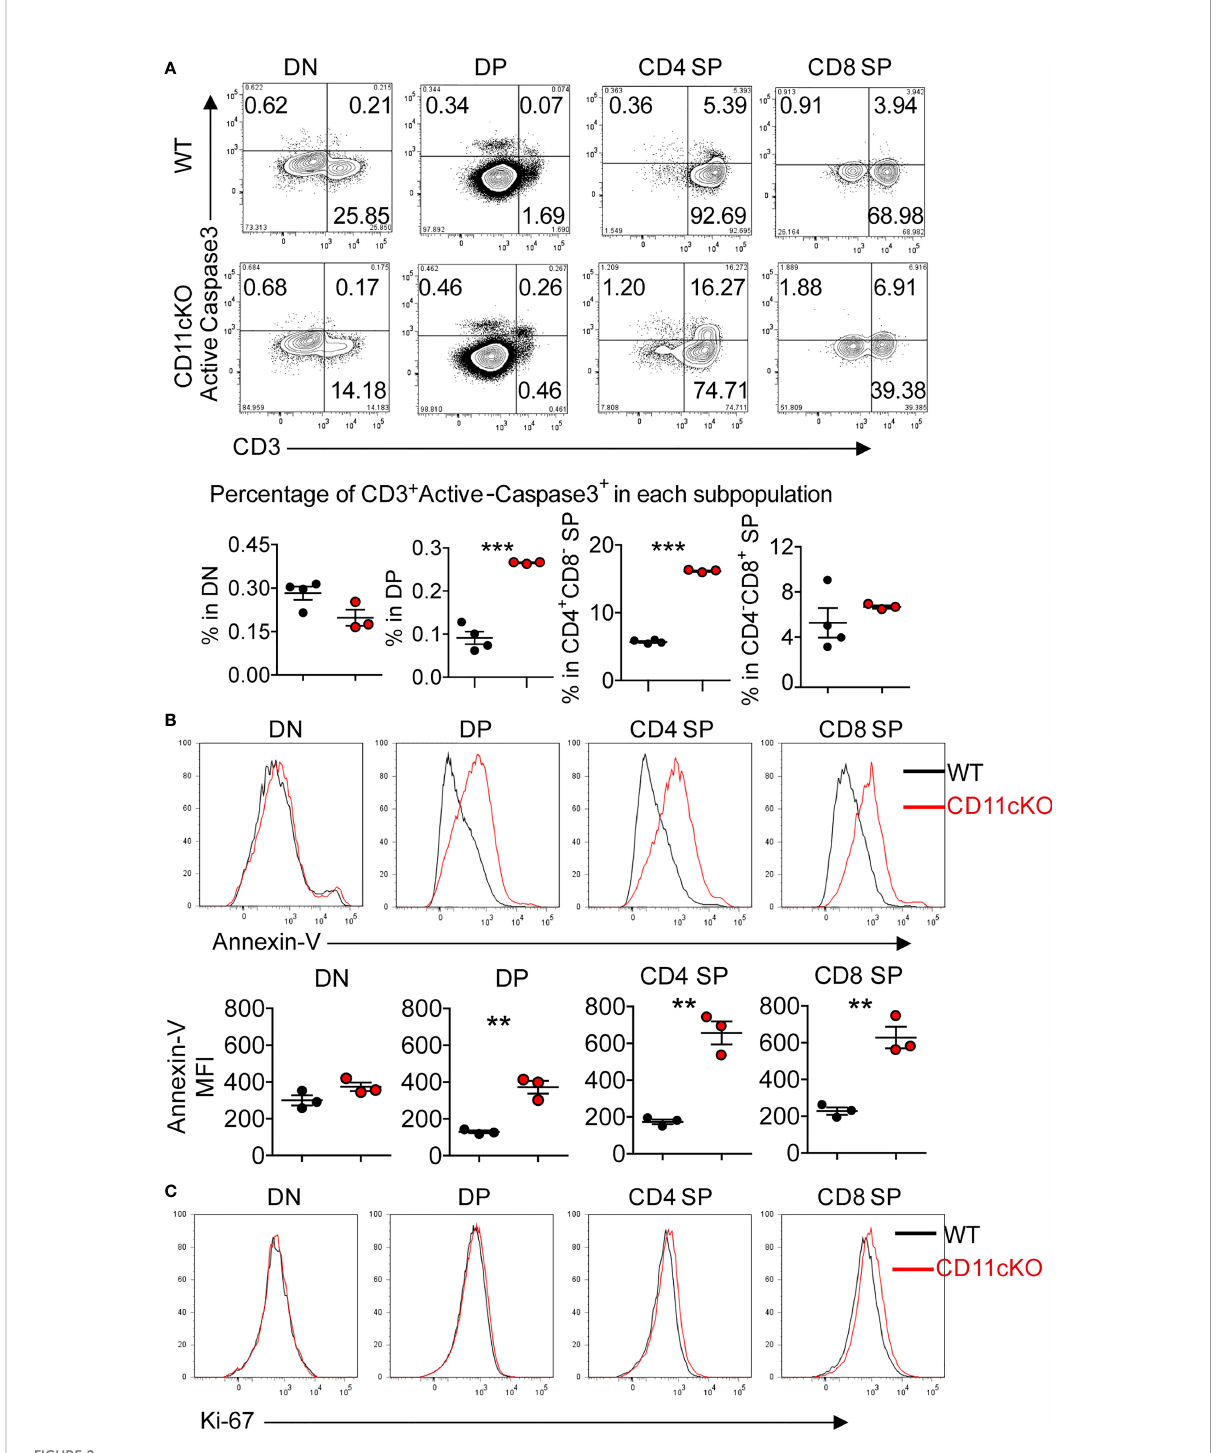
FIGURE 2 Apoptosis and proliferation analysis in CD11cKO mice. (A) Up panel: representative FACS data gated on different thymic T cell subsets with active cleaved caspase 3 expression; Bottom panel: Dot plots of percentage of CD3 + Active-caspase3 + cells in indicated subsets. (B) Up panel: representative Annexin-V staining overlay analysis, gated on different thymic T cell subsets; Bottom panel: MFI. (C) Representative Ki-67 staining overlay analysis, gated on different thymic T cell subsets. Each symbol represents an individual mouse. Experiments were repeated at least 3 times with the same pattern. (A) and (B) , Student t test was used for statistical analysis. **p < 0.01, ***p <